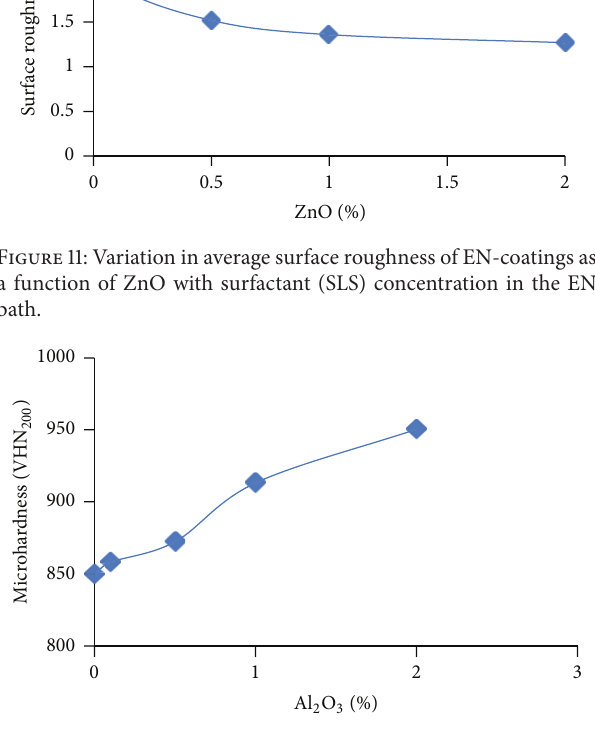
Figure 12: Variation in microhardness of EN-coatings as a function of Al 2 O 3 with surfactant (SLS) in EN bath.